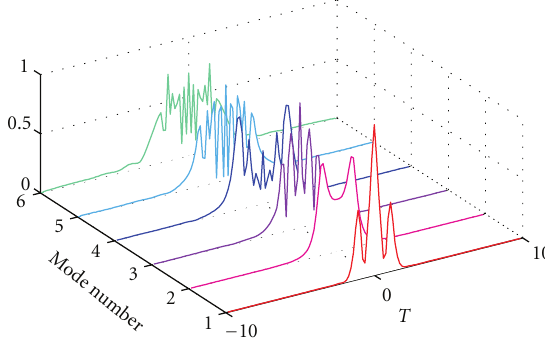
Figure 11: POD modes taken from the combined data set for the 0th waveguide that are capable of qualitatively reproducing the dynamics observed in the full WGAML